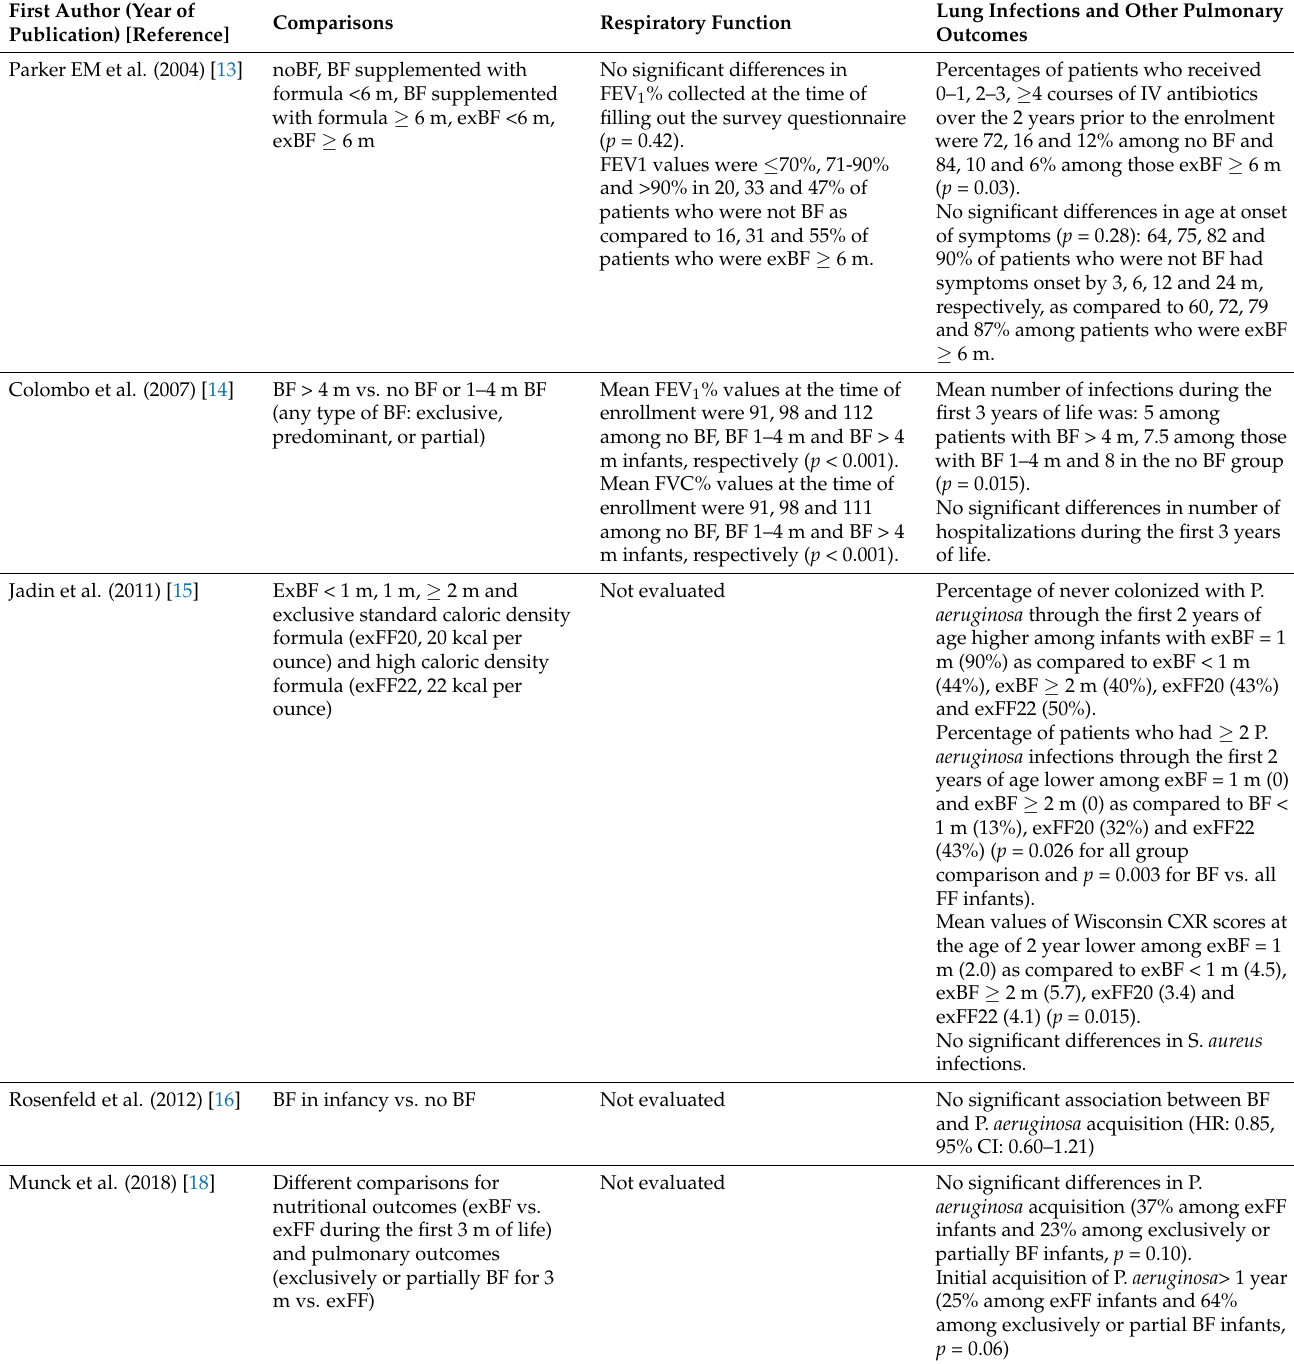
Table 5. Summary overview of the studies evaluating the association between breastfeeding and pulmonary outcomes in cystic